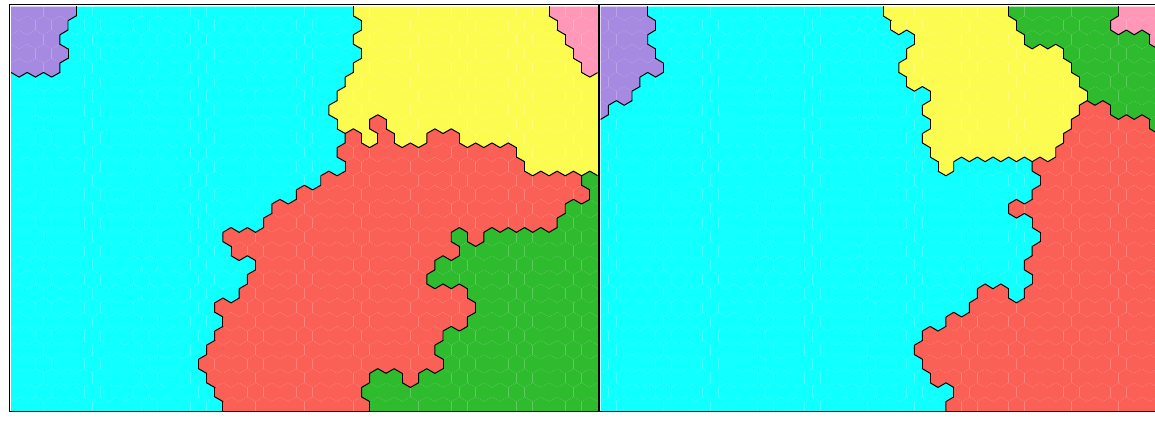
Fig. 3. General Kohonen